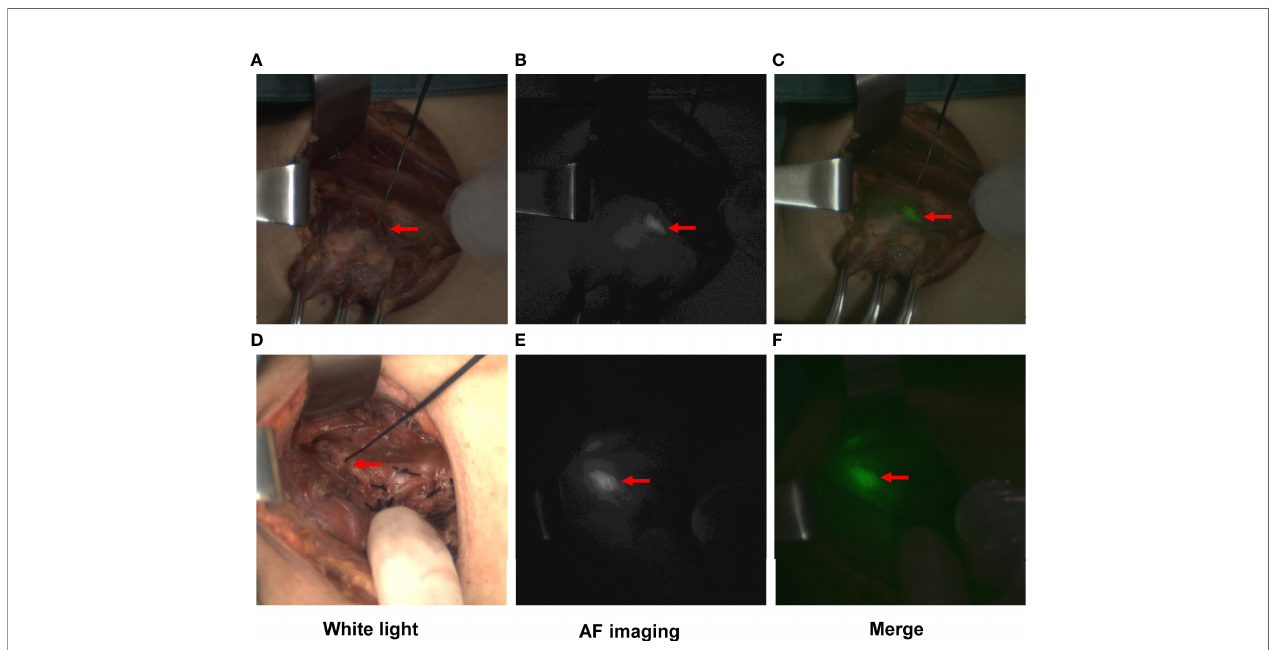
FIGURE 2 | Typical images of PGs visualized by auto fl uorescence (AF) imaging. PGs exposed to white light (A, D) , near-infrared light (B, E) , and the merged images (C, F) . Images (A – C) show the PG identi fi ed before any dissection. Images (D – F) show the PG in situ detected by AF after complete removal of the thyroid